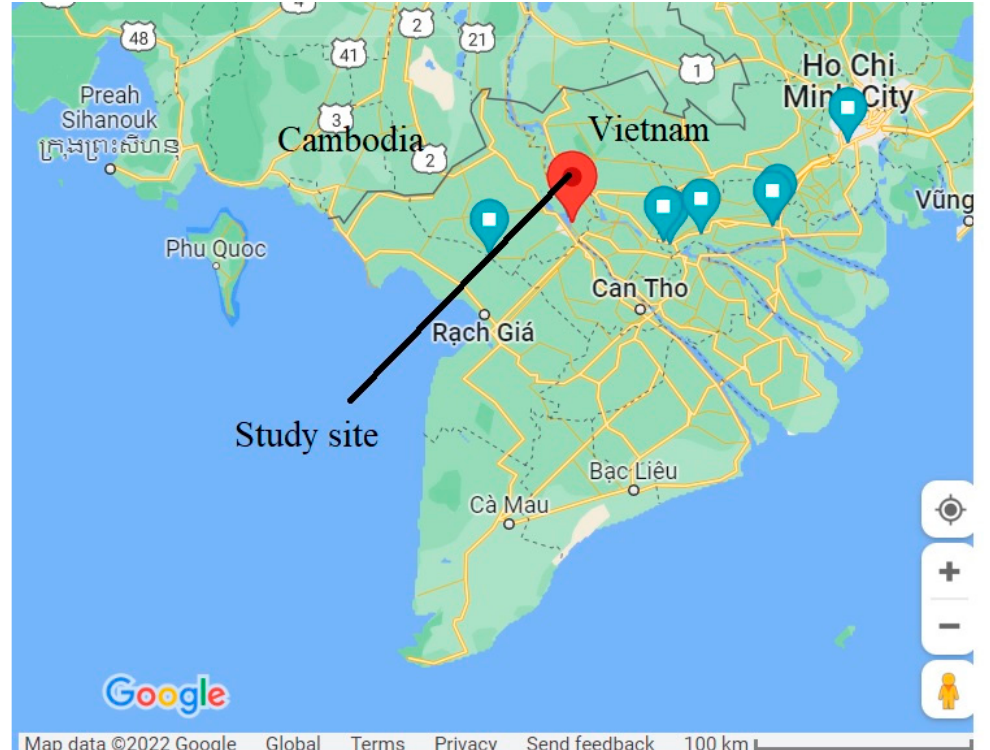
Figure 1. Study location. Table 1. Summary of the climatic features in the experiment site.